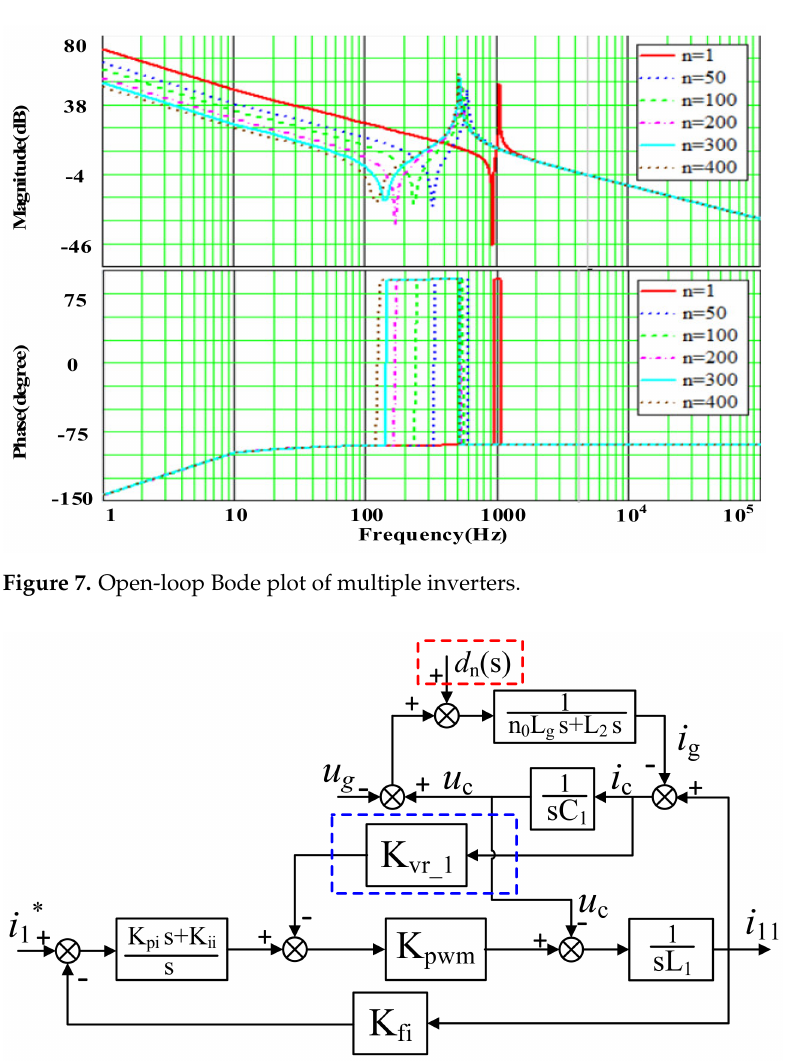
Figure 8. Equivalent control block diagram of a single inverter when multiple inverters are connected to the grid.